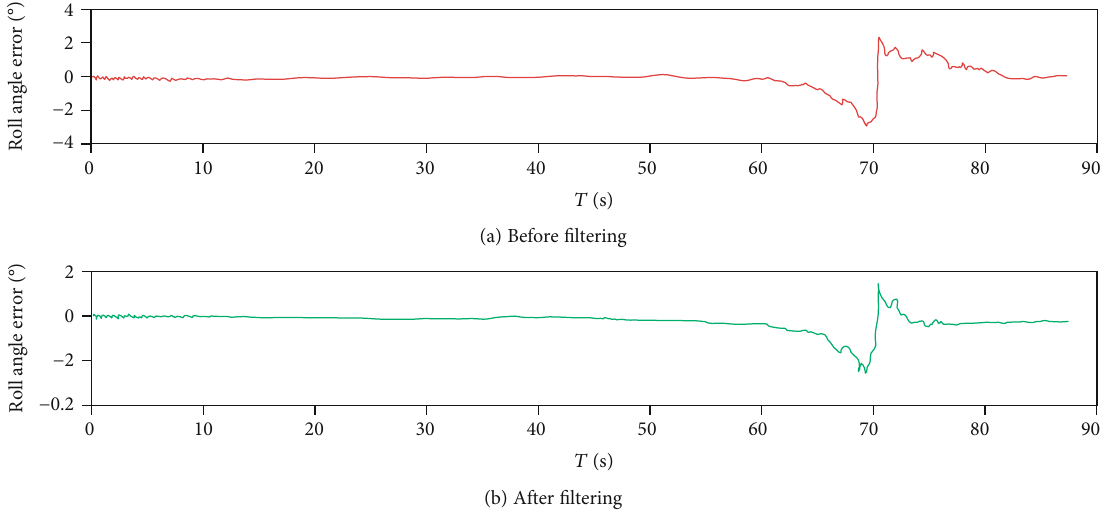
Figure 9: Comparison of roll angle error before and after fi